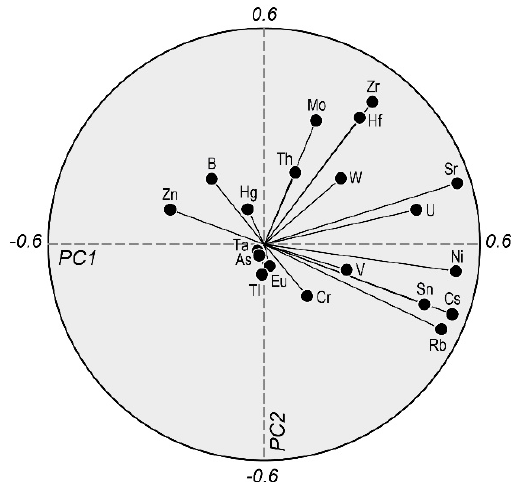
Figure 6. PC loading plots for 20 trace elements in Ca-HCO 3 -type bottled water in South Korea ( n = 33). The seven shaded elements in Table 3 are not shown.